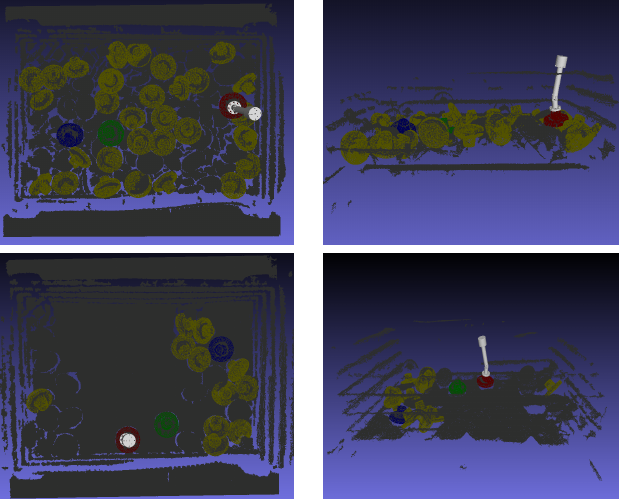
Figure 10. Qualitative results. Left panels correspond to a top view. Right panels correspond to a side